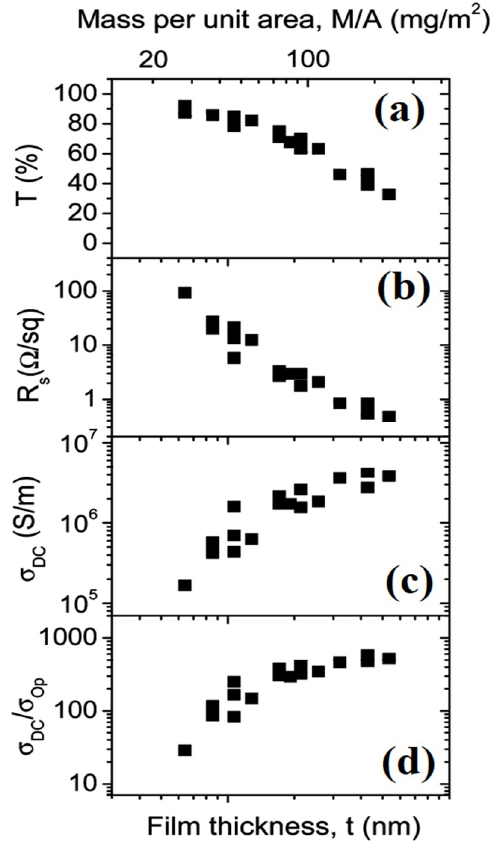
Figure 7. Changing the different characteristic of Ag NW thin film by increasing the film thickness: ( a ) optical transmittance (at 550 nm); ( b ) sheet resistance; ( c ) DC conductivity; and ( d ) σ DC /σ Op . Reproduced with permission from [16]. Copyright 2009 ACS Publishing.